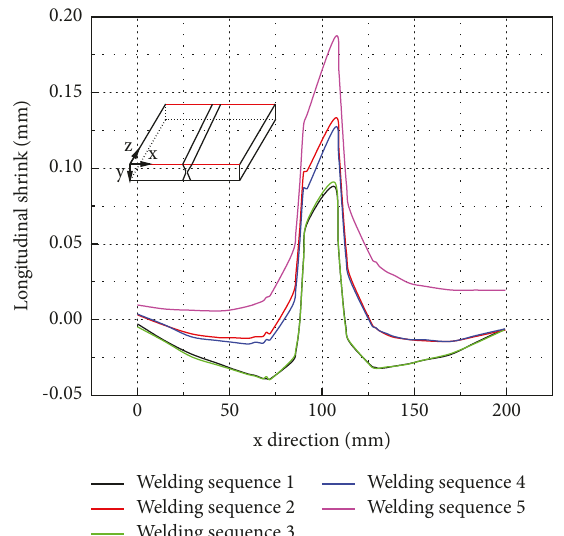
Figure 20: Comparison of the longitudinal shrinkage.